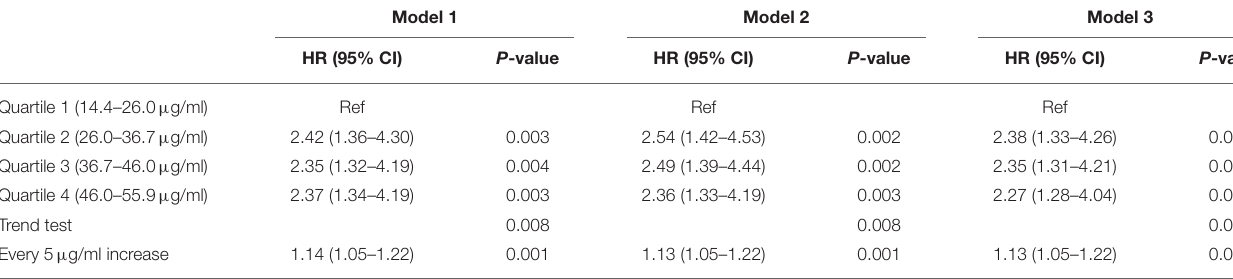
TABLE 3 | The associations of circulating RBP4 concentration and MACEs in patients with stable